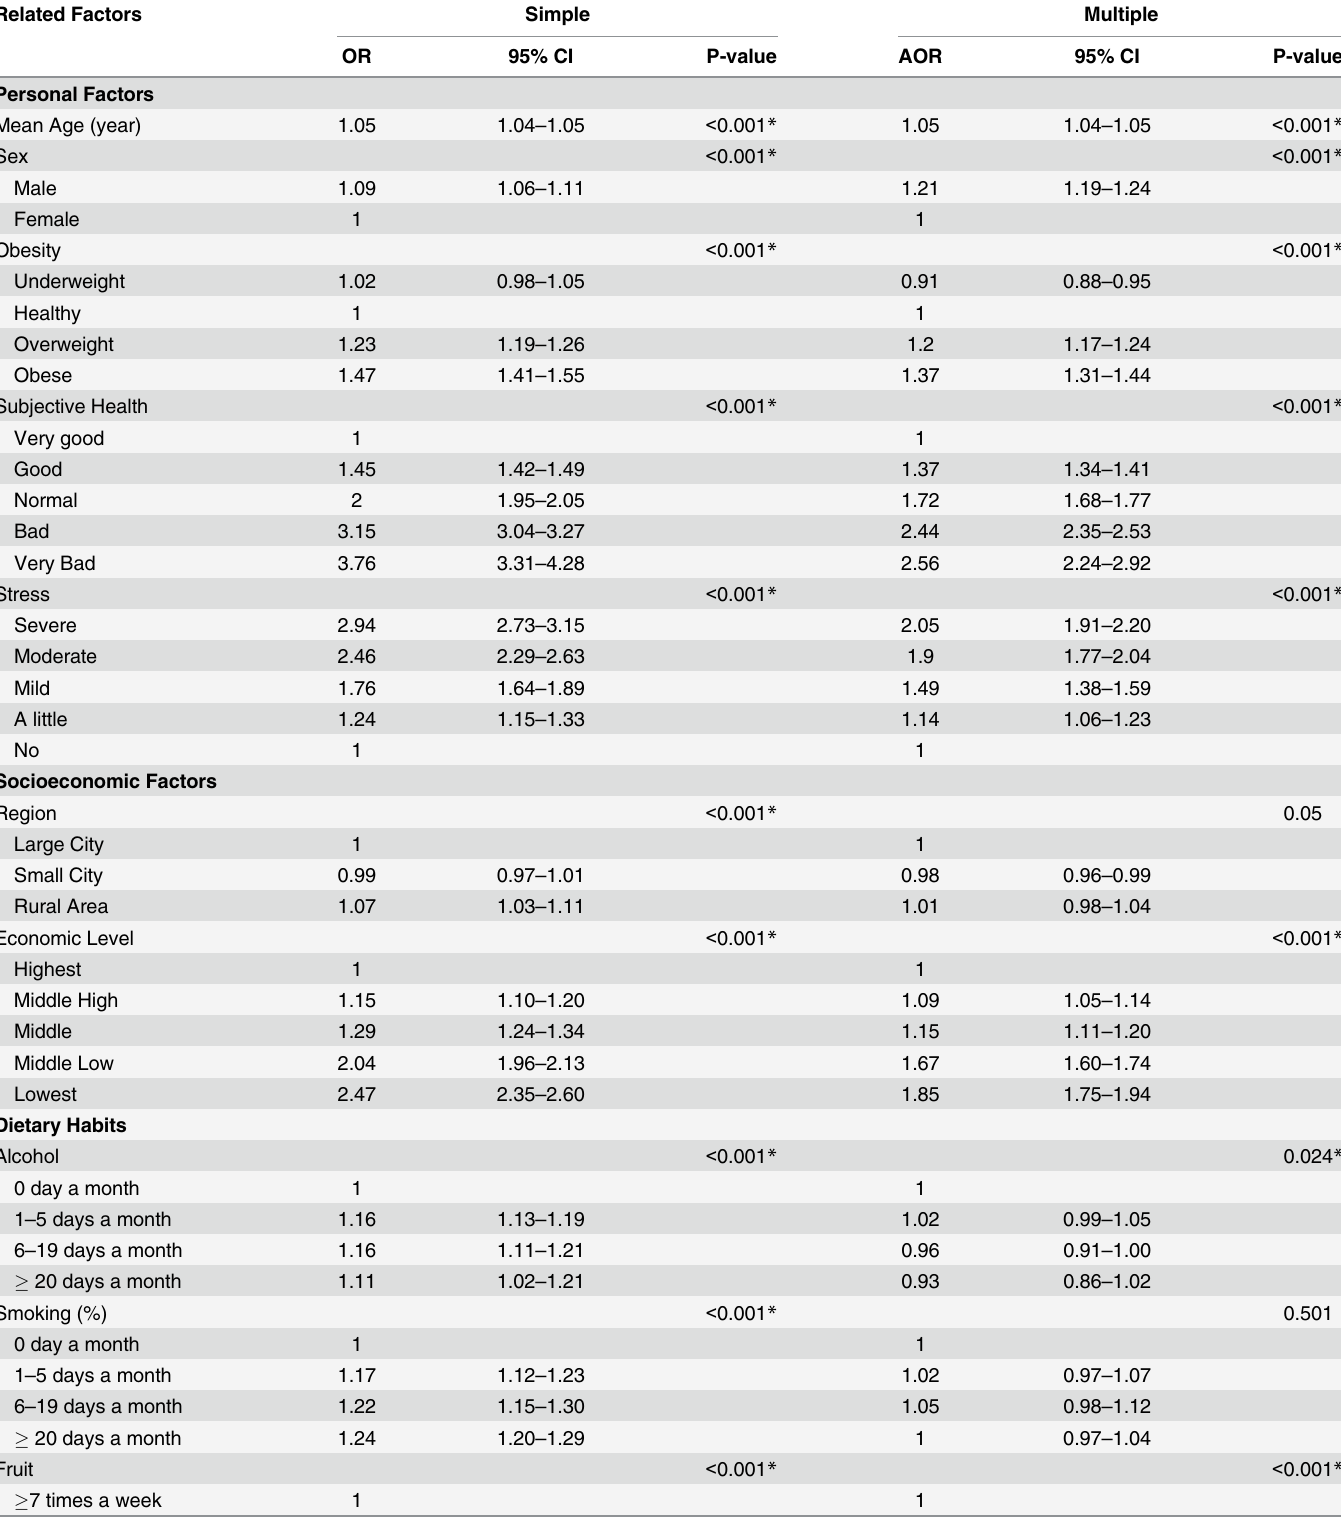
Table 2. Odd ratio of possible risk factors for halitosis using simple and multiple logistic regression analysis with complex